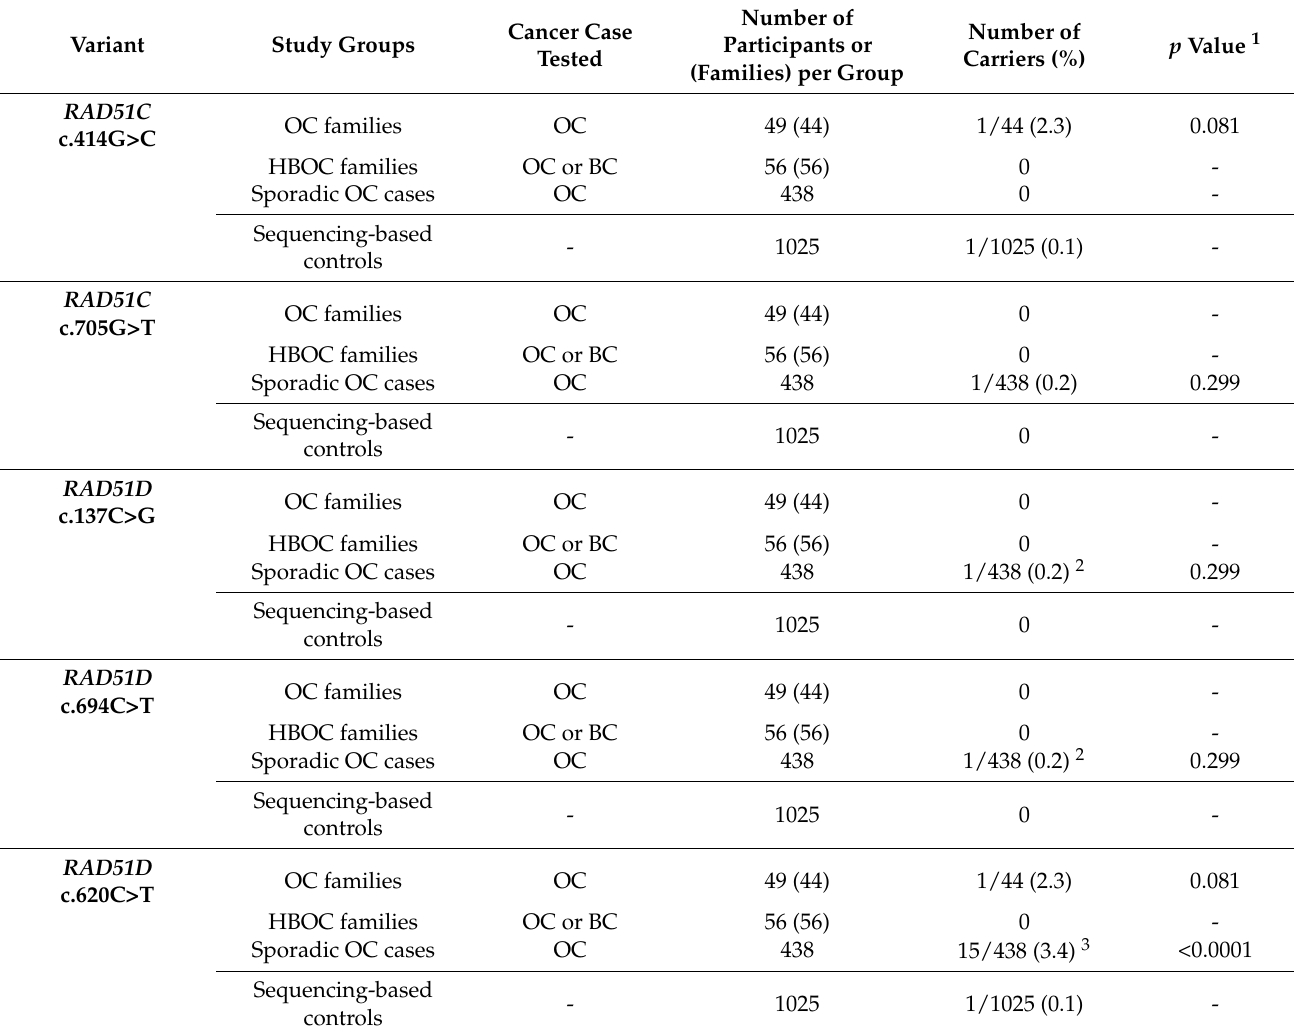
Table 2. Carrier frequency of candidate variants in French Canadian study groups and comparison of cancer cases to